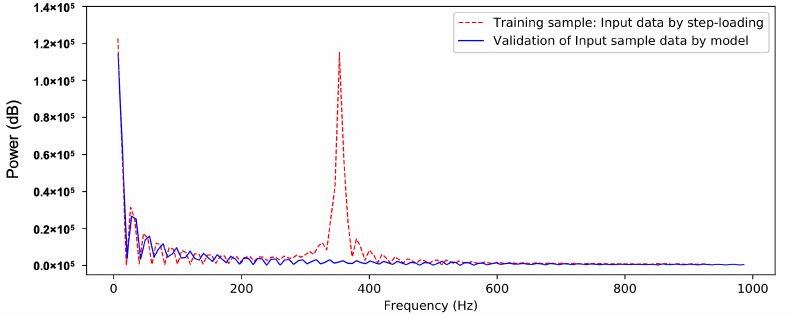
Figure 9. Data processing and comparison by FFT (axial force).